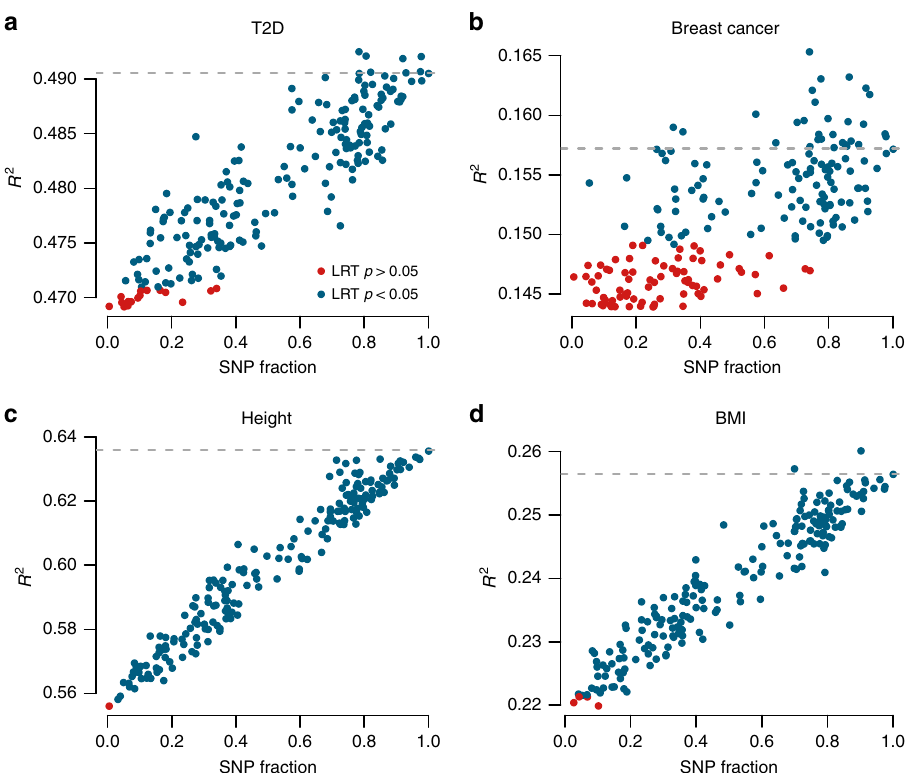
Fig. 3 pPS predictivity. We plugged in four trait prediction models pPS obtained with genomic subsets of variable sizes (the same resulting from local ancestry analysis in our admixed individuals), in a non-admixed sample set derived from EstBB. Each point represents the performance of a different subset of the genome, applied to all individuals in the population; on the horizontal axis is reported the fraction of genomic SNPs included in each subset, while the vertical axis represents its predictivity, expressed in R 2 (for binary traits we used Nagelkerke R 2 ). Red dots represent pPS not signi fi cantly improving the base model without PS ( p > 0.05, likelihood ratio test). The dashed line represents the total PS predictivity. ( a ) Type 2 diabetes, ( b ) breast cancer, ( c ) height, ( d )